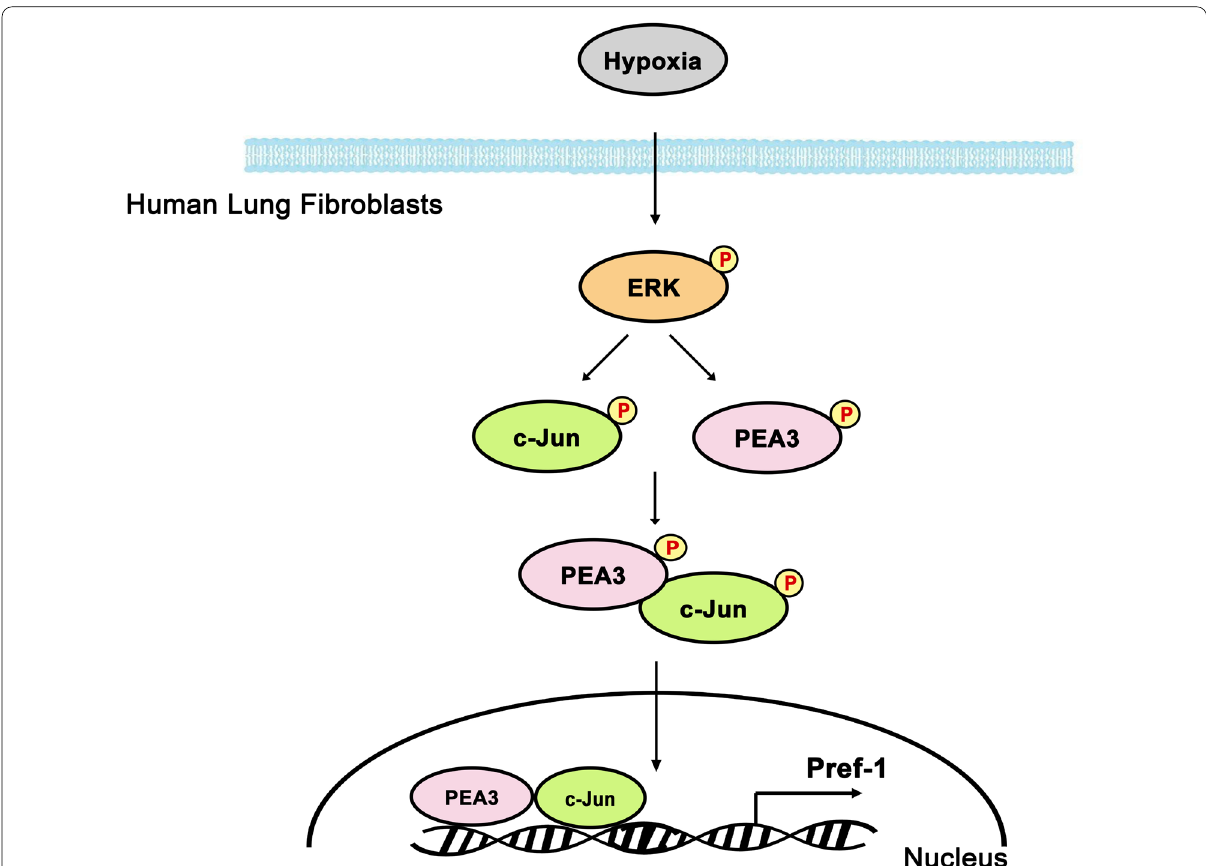
Fig. 6 Simplified image displaying the results of the expression of hypoxia‑induced Pref‑1 through the ERK/PEA3/AP‑1 pathway in human lung fibroblasts. Hypoxia induced the activation of ERK, which in turn caused PEA3 and AP‑1 phosphorylation and complex formation. Moreover, PEA3 and AP‑1 complex mediates Pref‑1 expression through hypoxia stimulation in human lung